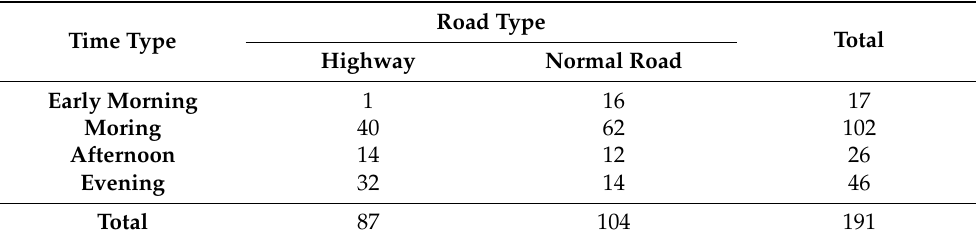
Table 1. The collected 191 videos were divided into time and road types for testing.